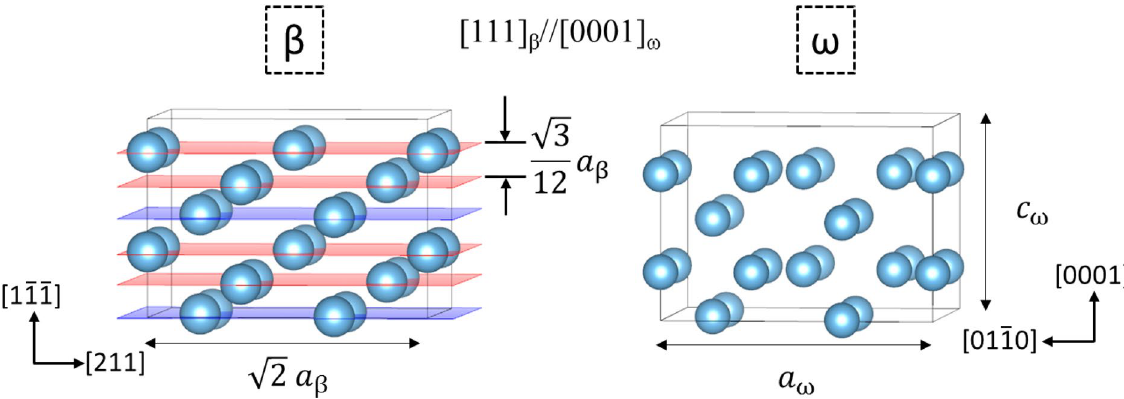
Figure 2. Shows the {111} β plane collapse and the orientation relationship between β and ω.